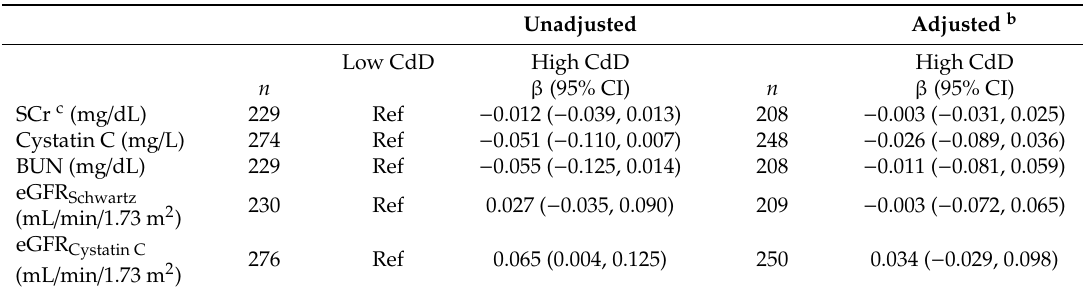
Table 4. Association between TWI dietary cadmium exposure (high vs. low) a at 1-year and kidney function parameters in 9-year-old children.